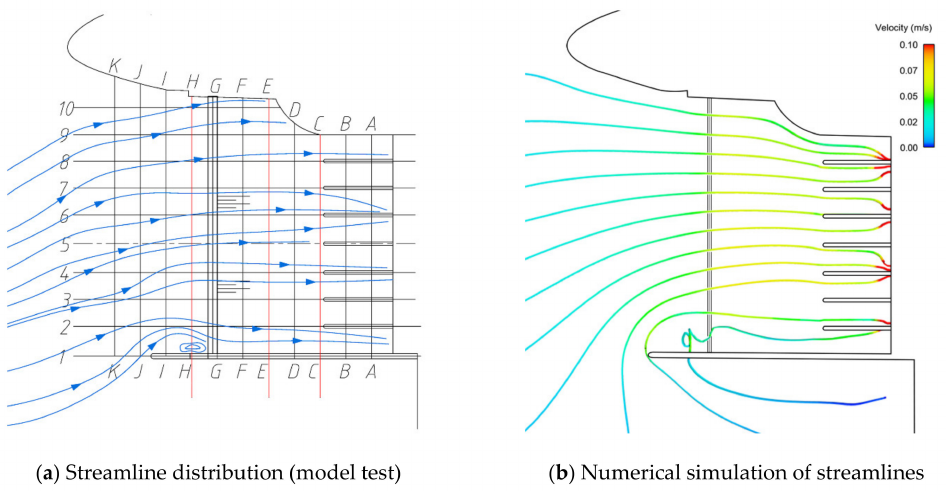
Figure 24. Plan 7 (design operating water